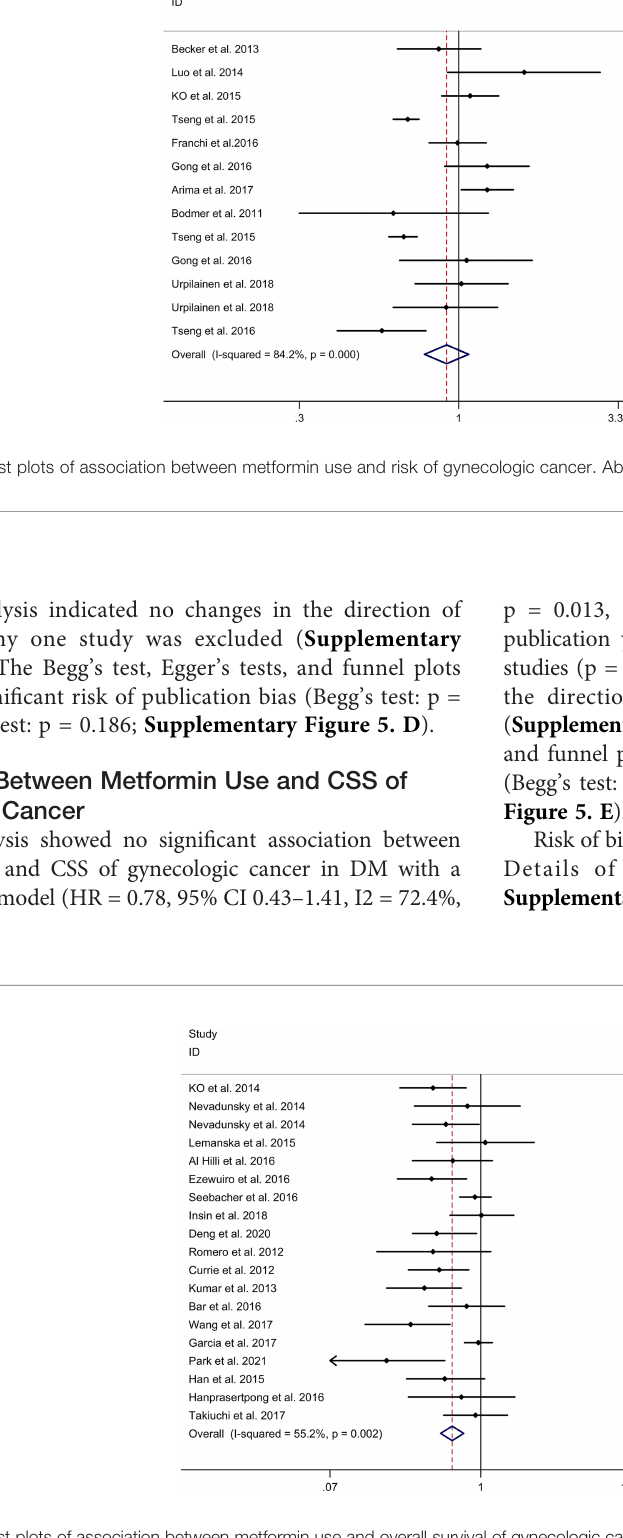
FIGURE 3 | Forest plots of association between metformin use and overall survival of gynecologic cancer. Abbreviation: HR, hazard